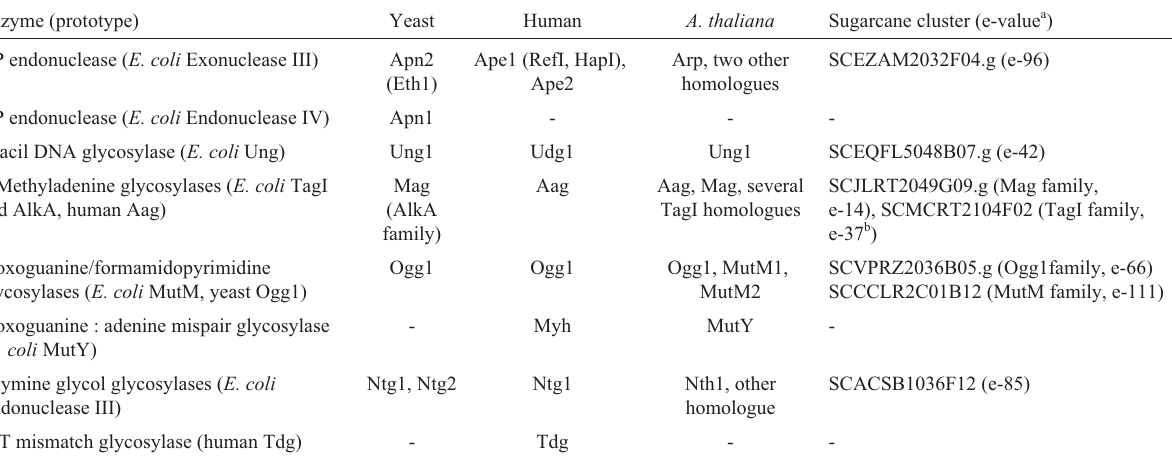
Table II - Base excision repair related proteins and their homologues in different